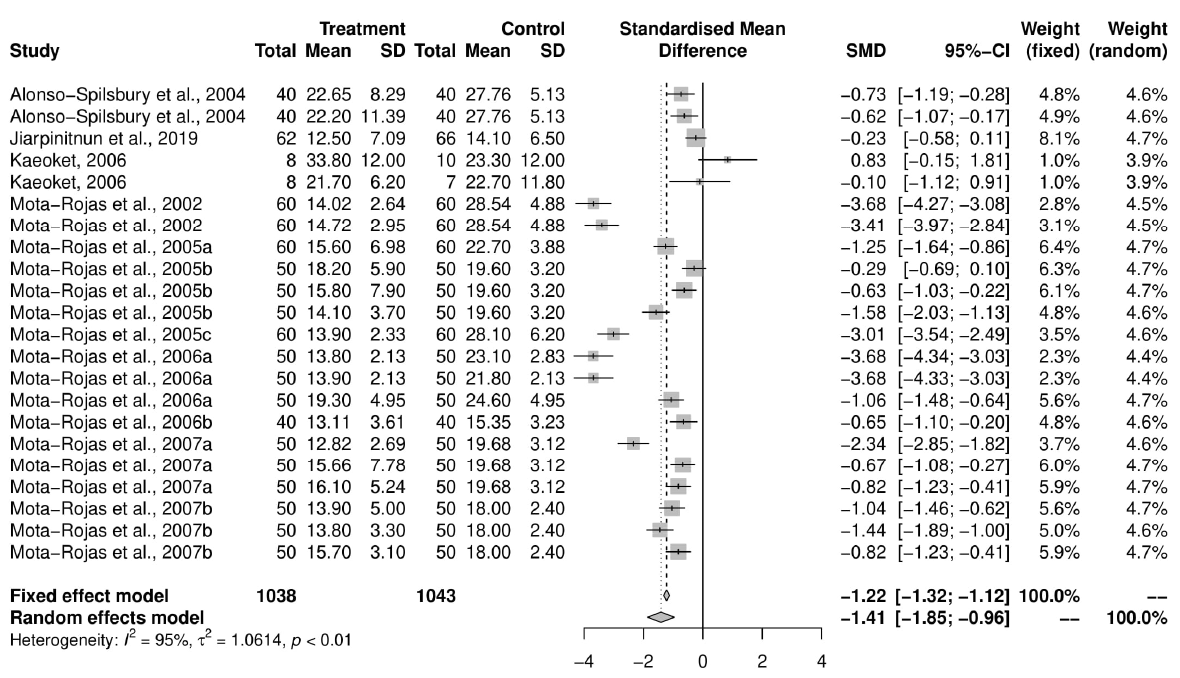
Figure 6. Meta-analysis examining mean birth interval between piglets